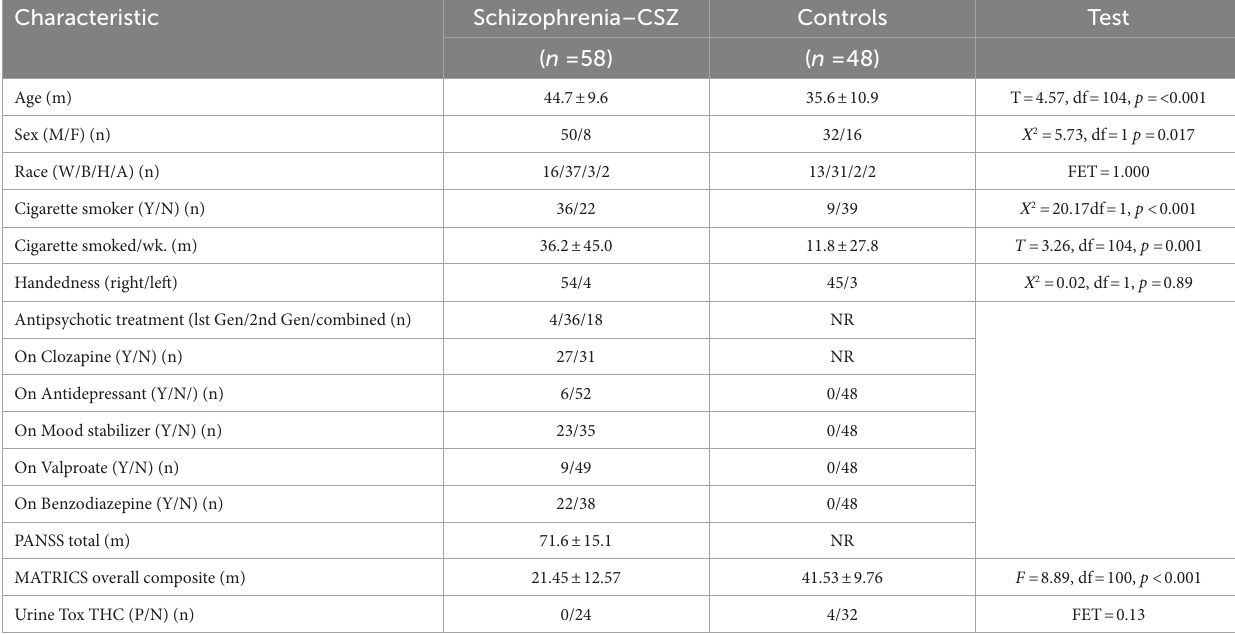
TABLE 1 Characteristics of subjects.